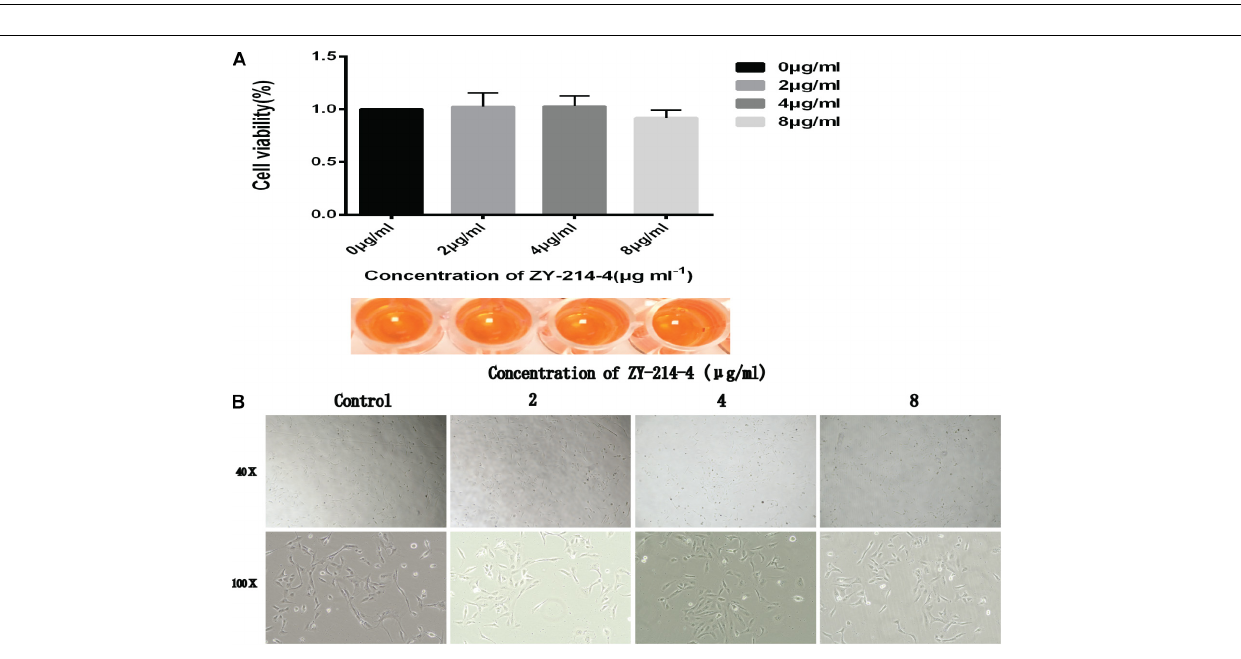
FIGURE 8 | Effect of ZY-214-4 on the growth and morphology of Bease-2B human normal bronchial epithelial cells. (A) CCK-8 assay. (B) Cell morphology and number evaluated by light